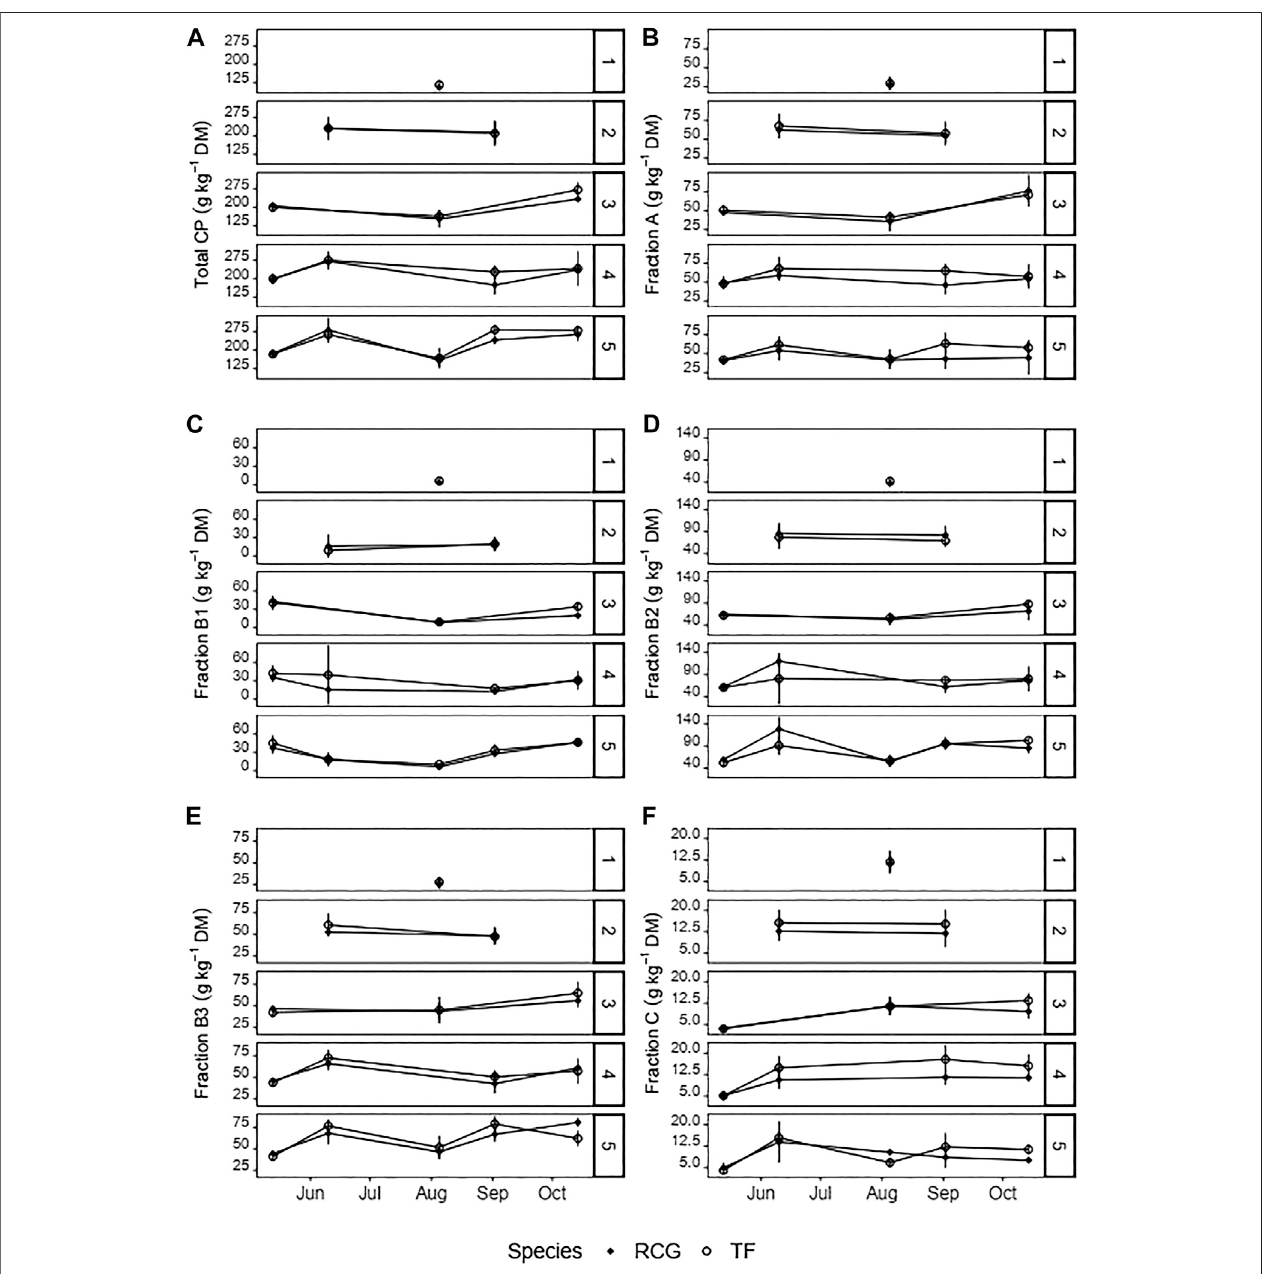
FIGURE3| Contentsof (A) crudeprotein(CP),and (B – F) proteinfractionsaccordingtotheCornellNetCarbohydrateandProteinSystem(CNCPS)inthebiomass (g kg − 1 DM) for the various treatments and species on the different harvest dates. Attention should be paid to the different magnitudes of the y-axes. Error-bars show standard